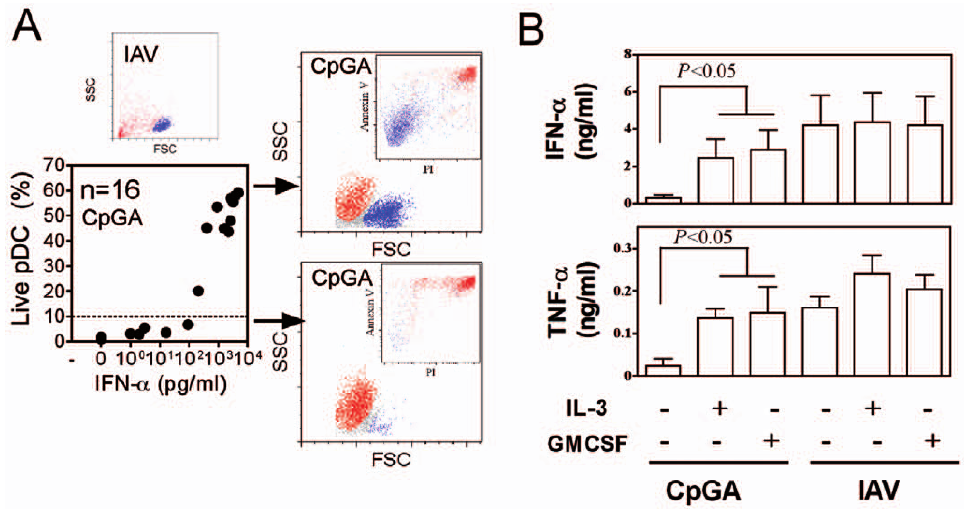
Figure 3. Survival fate of neonatal pDC following CpG activation. (A) IFN- a responses of neonatal pDCs to CpGA were plotted against the survival rate. Cell survival is shown by annexin V and propidium iodide staining (PI). (B) Neonatal pDCs were stimulated with CpGA or IAV in the absence or presence of IL-3 (10 ng/ml) or GMCSF (10 ng/ml) for 24 hrs. IFN- a was detected from supernatants.